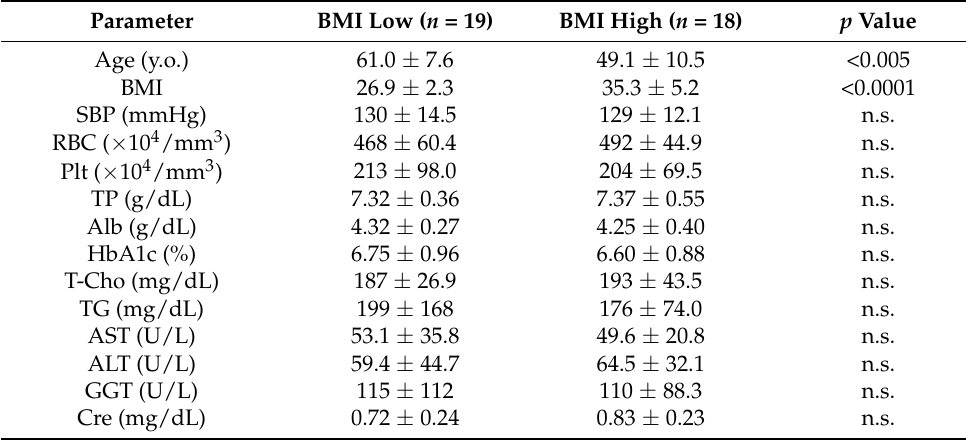
Table 6. Comparison of clinical data (BMI Low group, BMI High group).